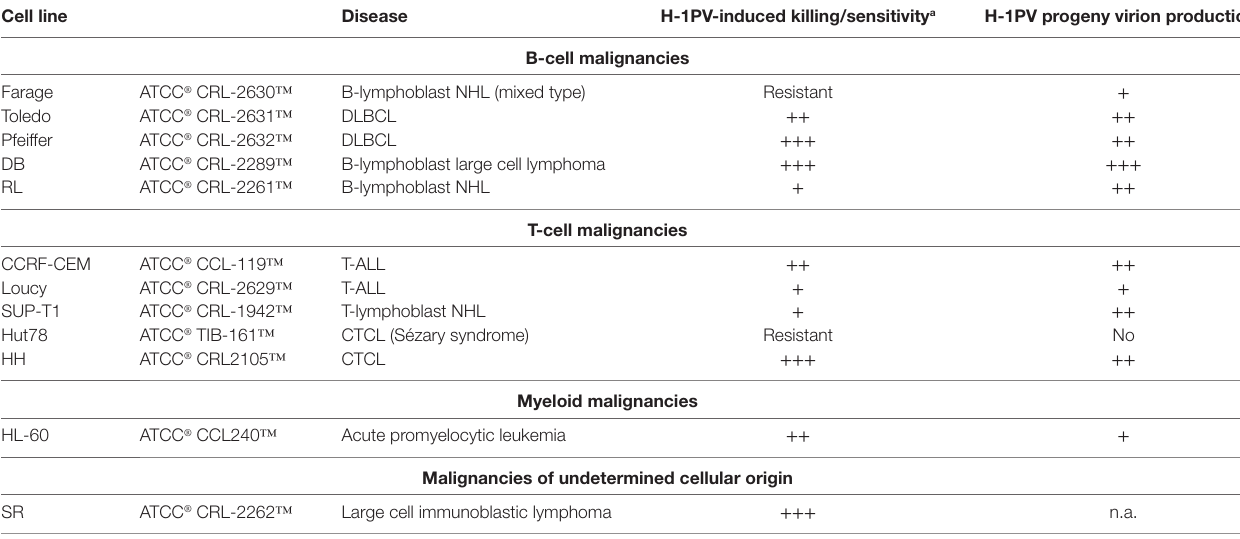
tABLe 2 | responsiveness of lymphoma- and leukemia-derived cell lines to oncolytic H-1Pv infection. cell